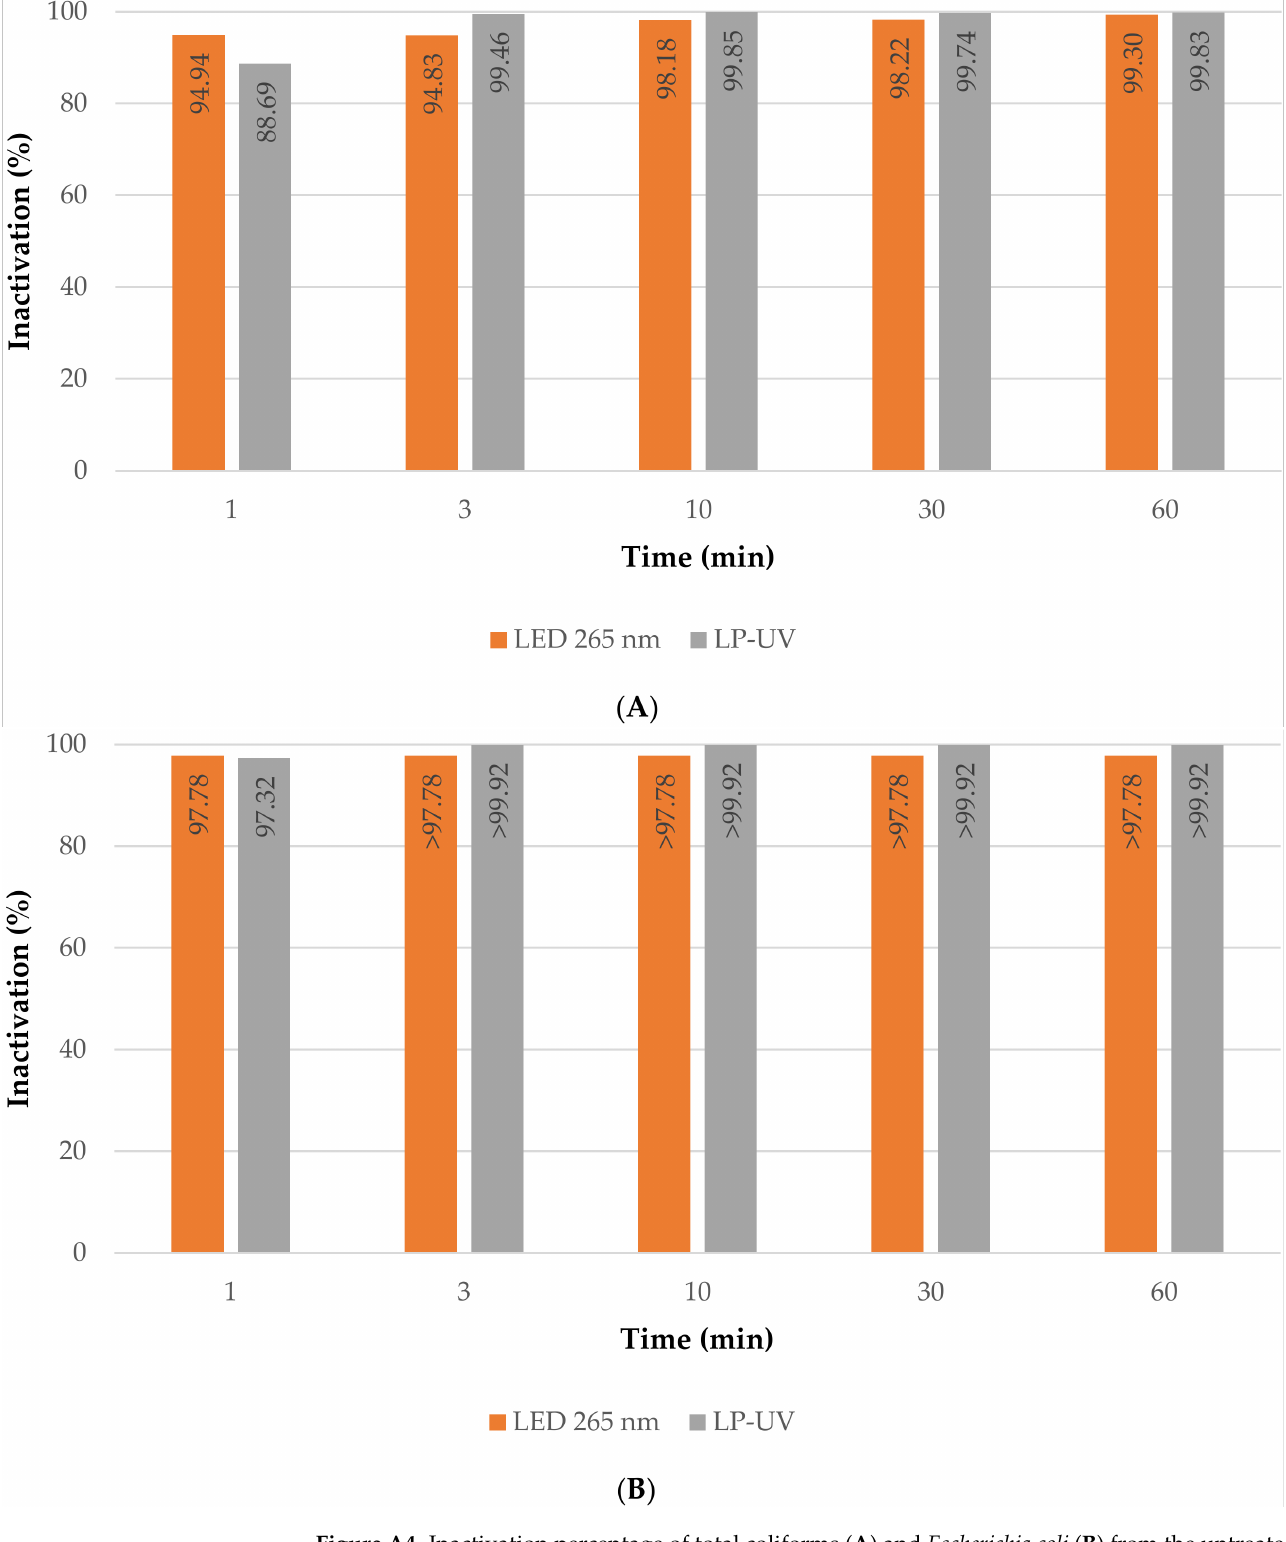
Figure A4. Inactivation percentage of total coliforms ( A ) and Escherichia coli ( B ) from the untreated surface water samples with LEDs emitting at 265 nm and low-pressure ultraviolet lamps (LP-UV) after 1, 3, 10, 30, and 60 min. Values marked “>” indicate that the target microorganisms were not detected in the treated water